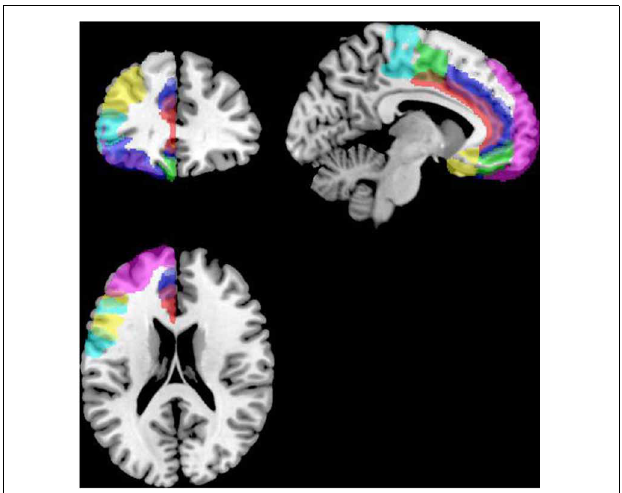
FIGURE 2 | Masks for the frontal cortex (only the left hemisphere is shown). ACC is shown in red, the OFC in blue, the MPFC in green, frontal pole in violet, IFG opercularis in yellow, IFG triangularis in cyan, juxapositional lobe in green, MFG in yellow, paracingulate in blue, precentral gyrus in light blue, SFG in grayscale and the subcallosal gyrus in yellow, displayed on the left hemisphere of a standard brain in neurological convention (left is left and right is right).